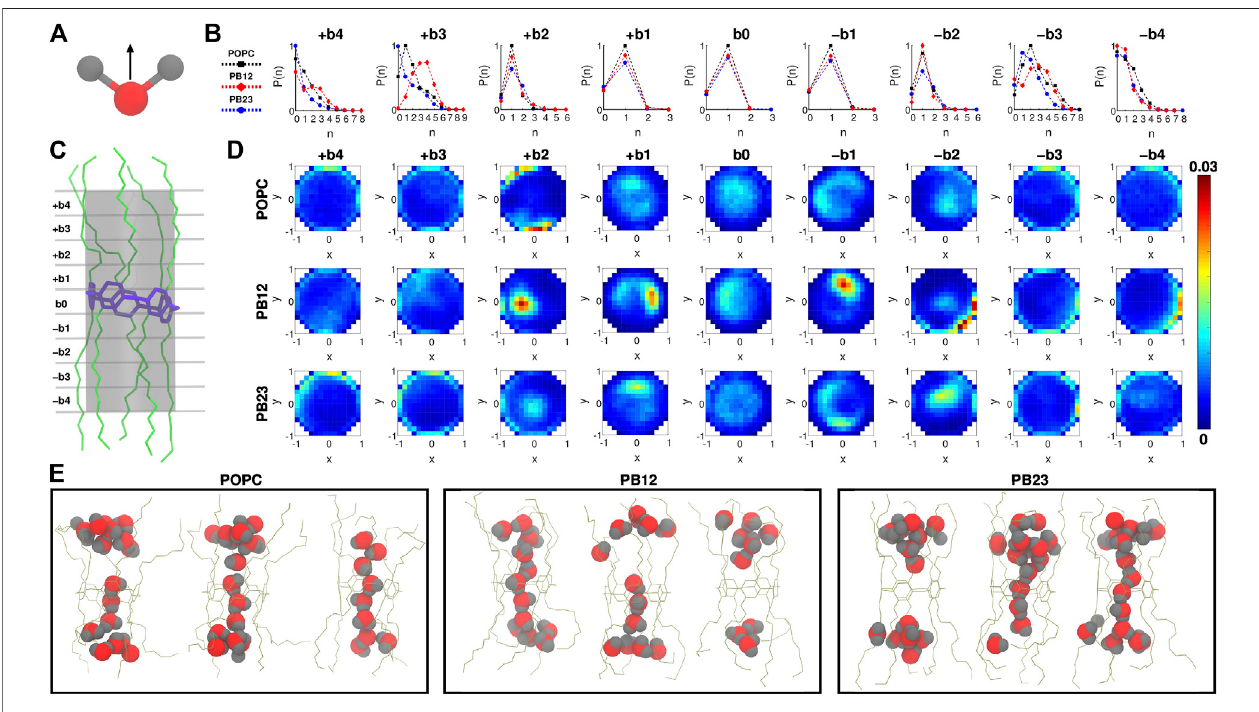
FIGURE2|(A) Thedirectionvectoralongthedipolemomentofawatermoleculeishighlighted. (B) Probabilityof fi nding “ n ” watermolecules, P(n),ineachofthe9 binsisshown. (C) Asnapshothighlightingthe9binspartitioningthechannel,whereb 0 isthebinspanningthecentralpillar[5]areneringofthechannel,and+b i and − b i ( i (cid:2) 1,2,3,and4)arebinsaboveandbelowthecentralring. (D) Twodimensionalhistogramshighlightingthewaterorientationvia x - y planeprojectionsofthedipolevector of water molecules. (E) Snapshots highlighting water structure within PAP in each membrane.